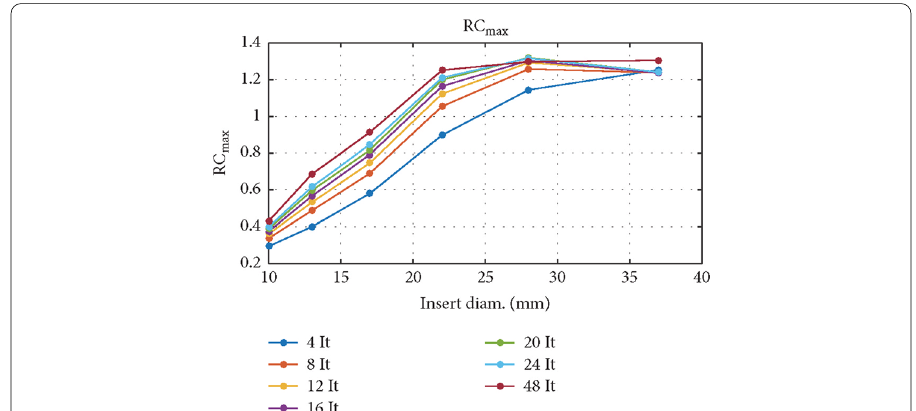
Fig. 11 Recovery coefficients (RC max ) for activity concentration in 6 spherical inserts of the NEMA/IEC NU2 Body Phantom scanned with Siemens Symbia Intevo SPECT/CT system [11] (Courtesy of Dr Silvano